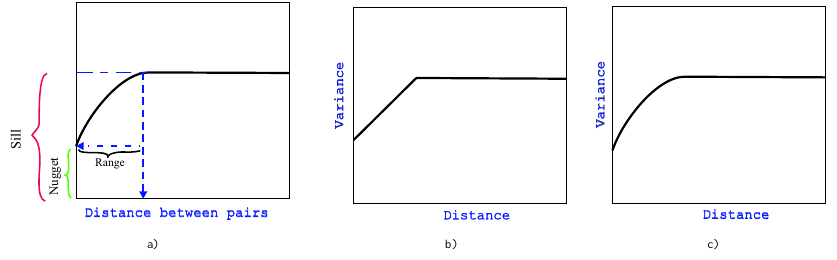
Figure 1. Variograms: a) idealized form of variogram function; b) linear variogram; c) sphe- rical